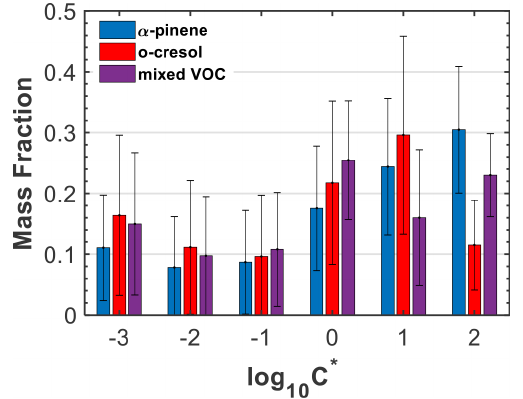
Figure 5. O : C enhancement ratio (i.e. O : C at the TD line divided by the corresponding O : C at the BP line) as a function of the par- ticle MFR in each system